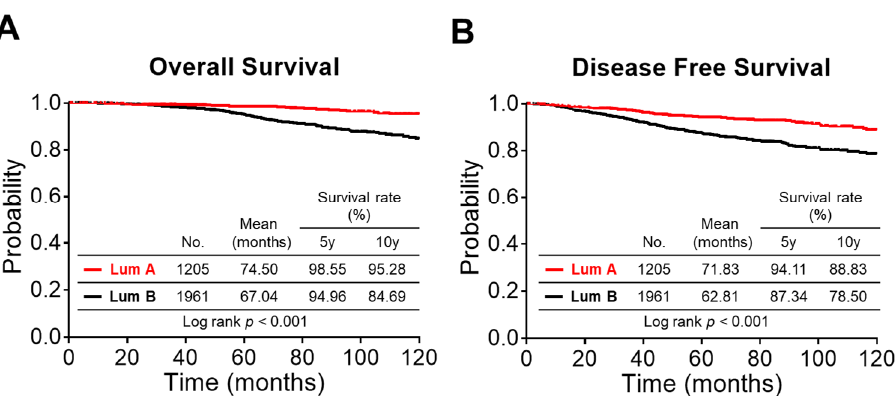
Figure 2. Survival analysis for HR + luminal BC at Chang Gung Memorial Hospital (2005–2013). ( A , B ) Overall survival ( A ) and DFS ( B ) curves for HR + luminal BC at Chang Gung Memorial Hospital (2005–2013). Lum A, luminal A ( n = 1205); Lum B, luminal B ( n = 1961). For group comparisons, p -values were determined by a log-rank test.